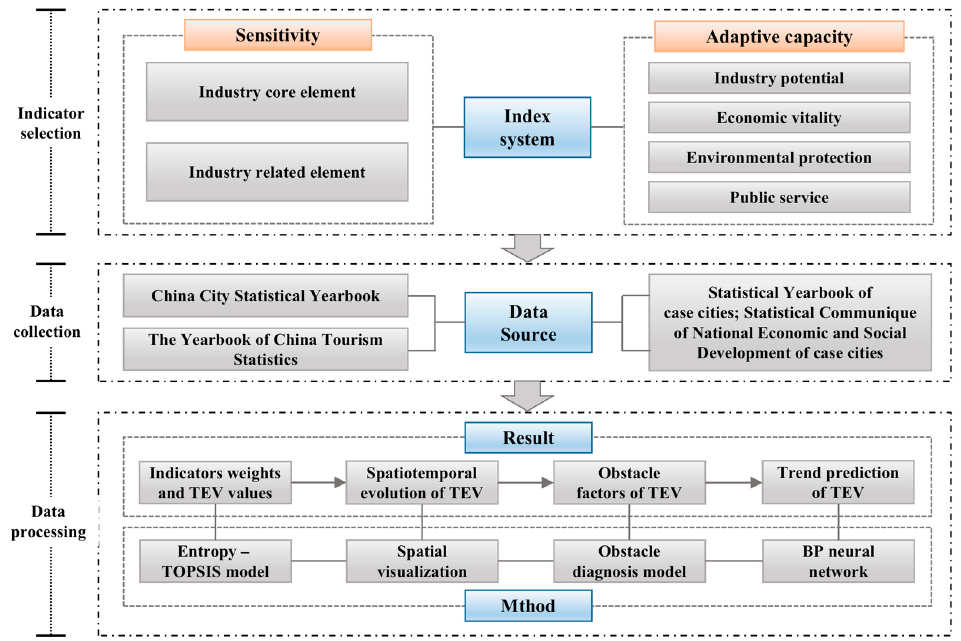
Figure 2. Research framework.